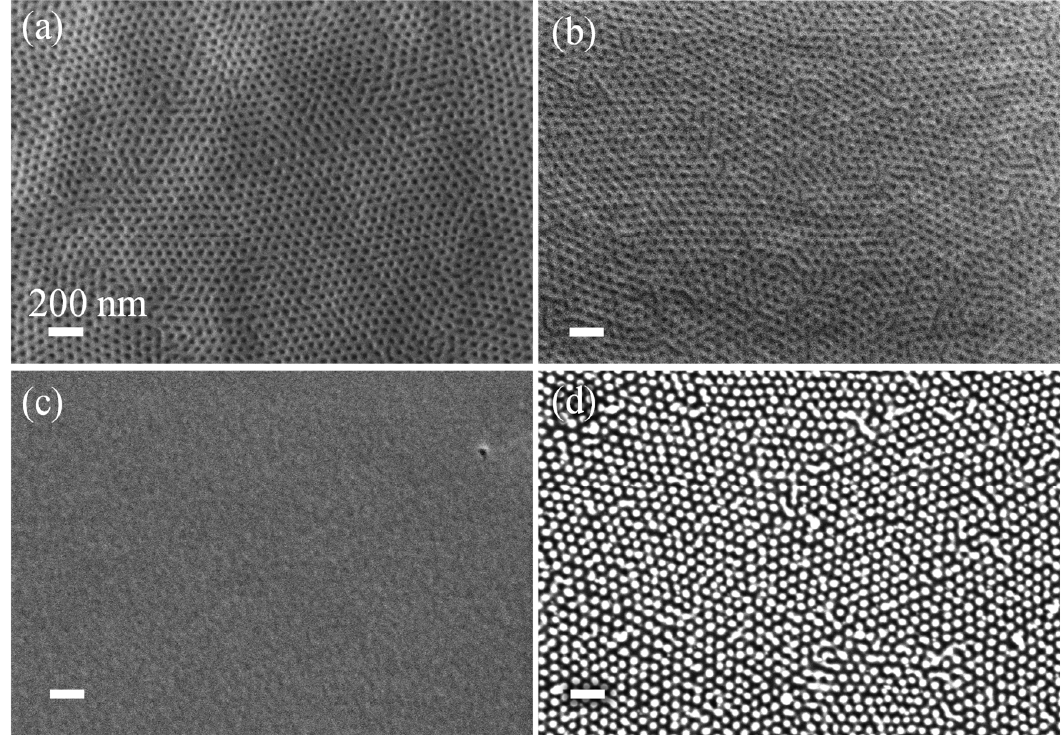
Figure 4. SEM images of PS- b -PMMA over SiO 2 /MR-8 substrate: ( a ) self-assembled, ( b ) after 3 h of heat treatment at 80 °C, and ( c ) after eight cycles of AlO x SIS. ( d ) SEM image of AlO x nanocylinders on SiO 2 /Si substrate fabricated using the same process as (c).